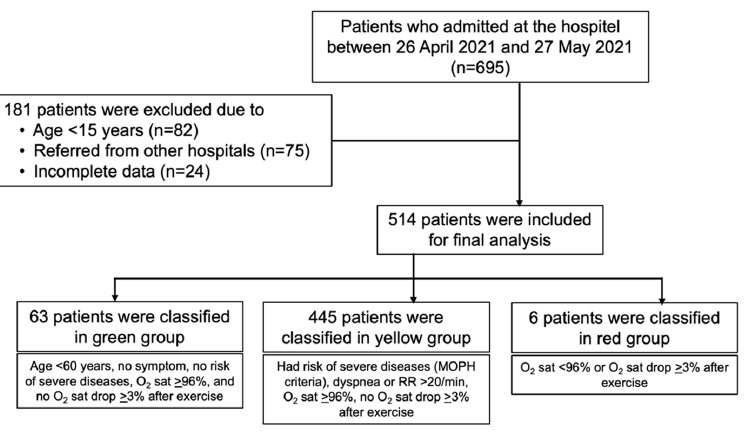
Figure 1. Study flow.